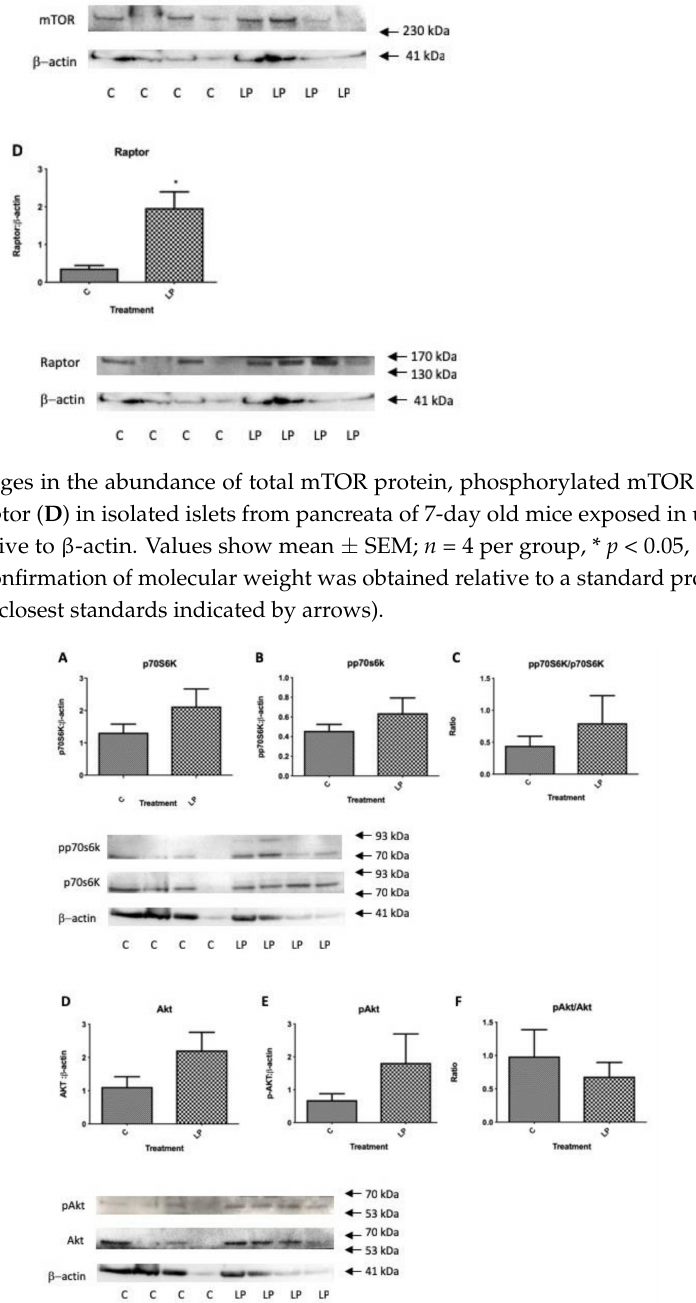
Figure 5. Changes in the abundance of total p70S6k, phosphorylated p70S6k and their ratio ( A – C ); and total Akt, phosphorylated Akt and their ratio ( D – F ) in isolated islets from pancreata of 7-day old mice exposed in utero to control or LP diet relative to β -actin. Values show Mean ± SEM; n = 4 per group, Confirmation of molecular weight was obtained relative to a standard protein molecular weight ladder (closest standards indicated by